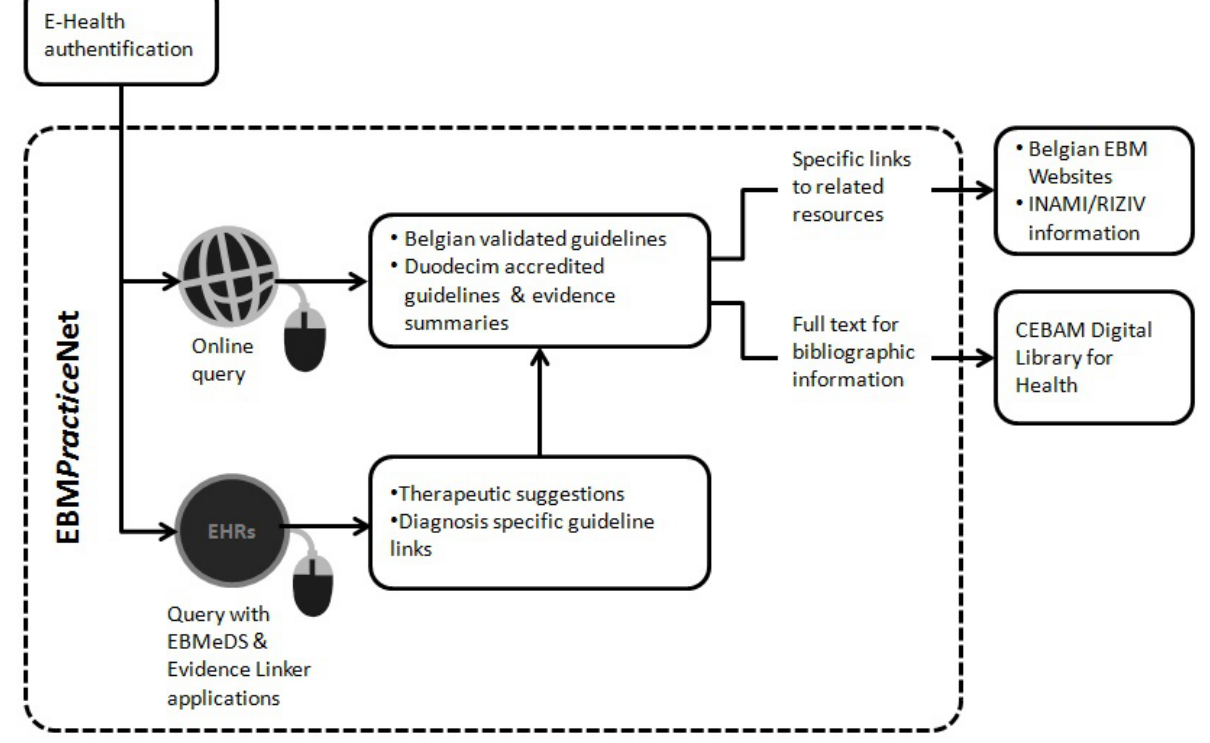
Figure 1. EBMPracticeNet information